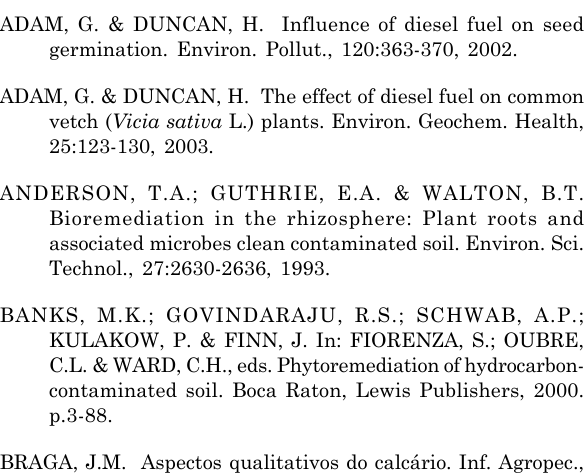
Figure 5. Effect of plant rhizosphere of B. brizantha , B. decumbens and P. notatum on bacterial numbers in soil contaminated with different diesel concentrations and after 4 (a) and 10 weeks (b) of treatment. The number of bacteria in soil with plants (R) divided by the number of bacteria in soil without plants (S) was used to estimate the rhizosphere